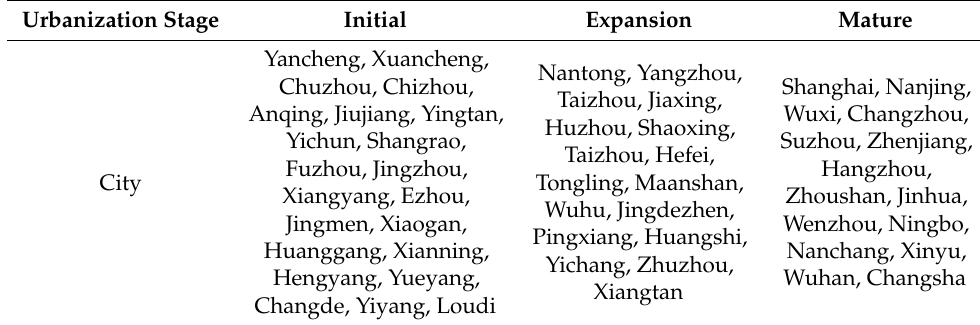
Table 4. Results of urbanization stage division. Urbanization Stage Initial Expansion Mature